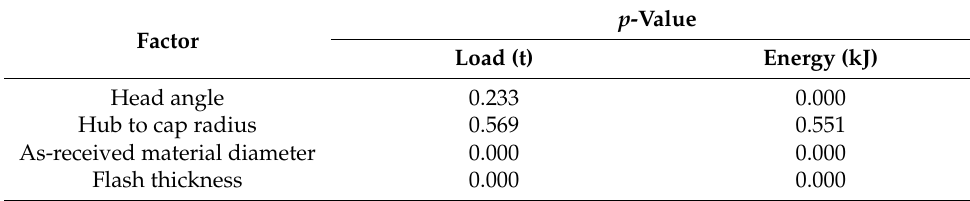
Table 6. Results of the p-value for the analyzed forging parameters.